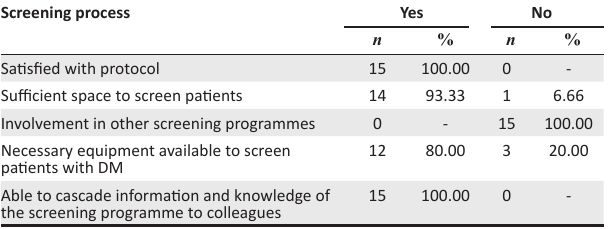
TABLE 7: Results of primary healthcare nurse and medical officers satisfaction survey completed by 15 primary healthcare nurses and one medical officers. Screening